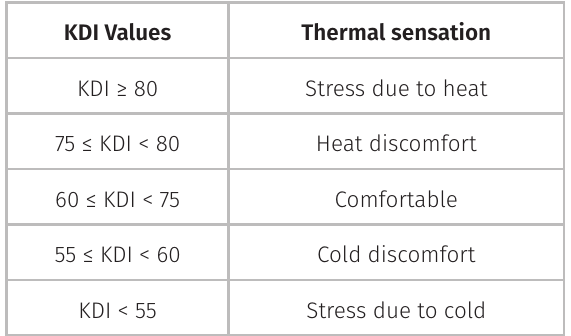
Table I. KDI classification. KDI